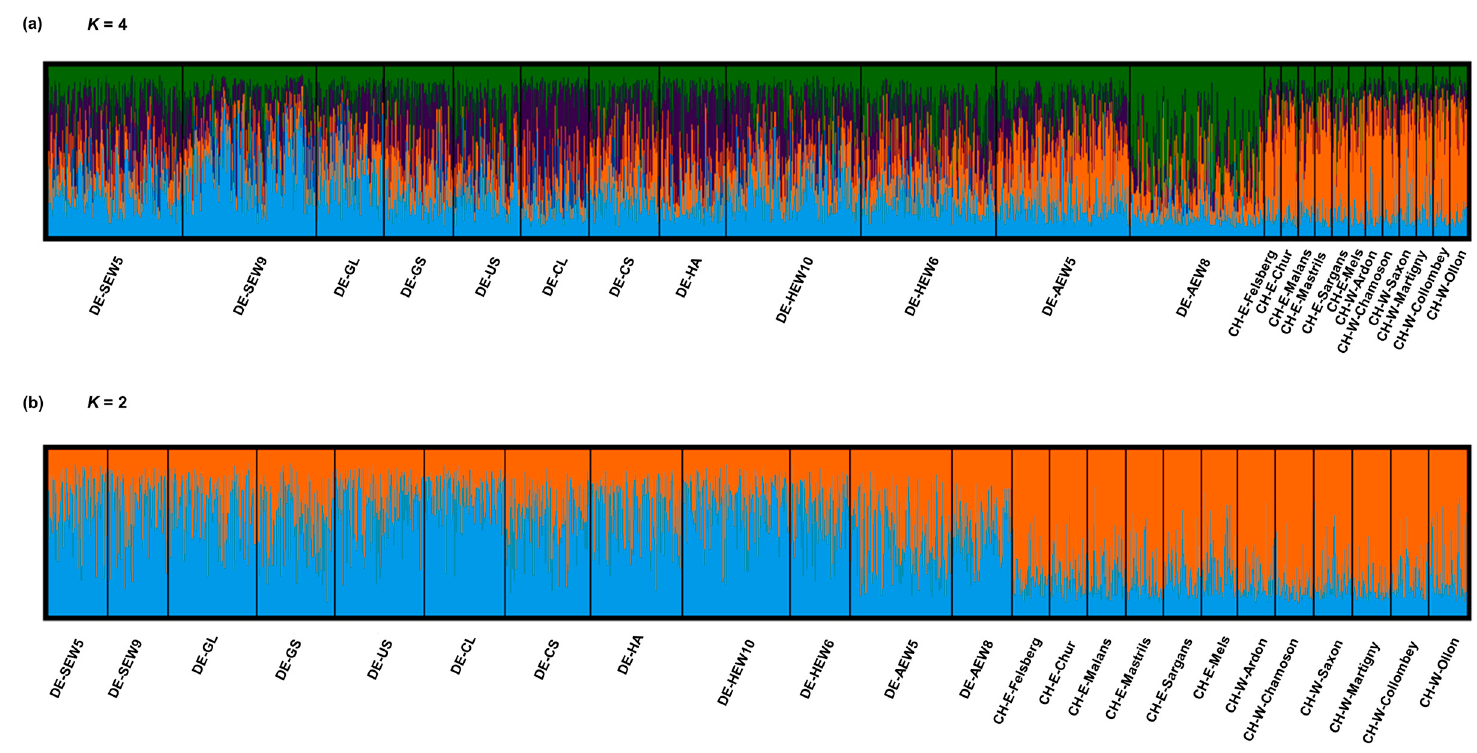
Figure 2. Clustering of individuals based on SSRs for the adult ( a ) and seedling ( b ) populations sorted from northeast to southwest.